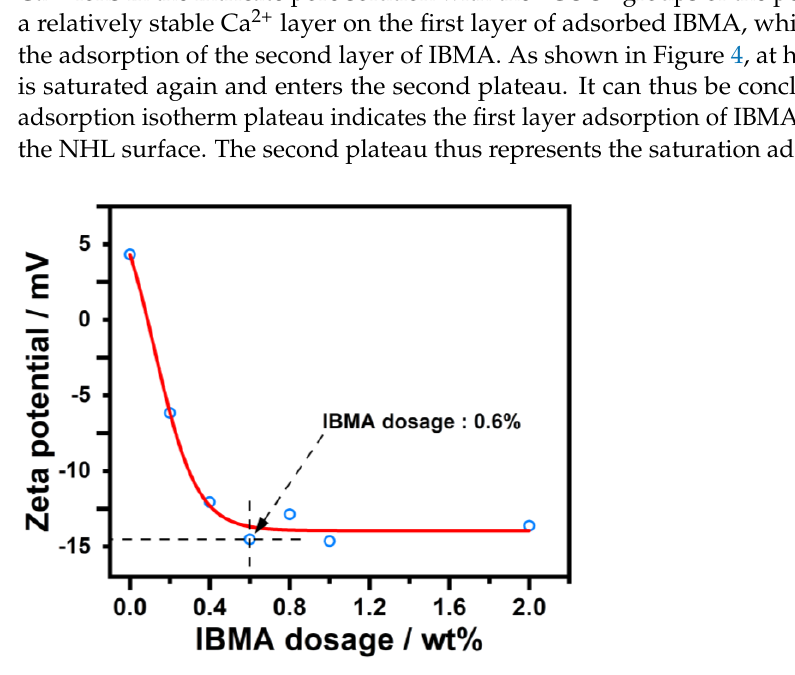
Figure 3. Zeta potential measurements of NHL pastes containing varying IBMA content.